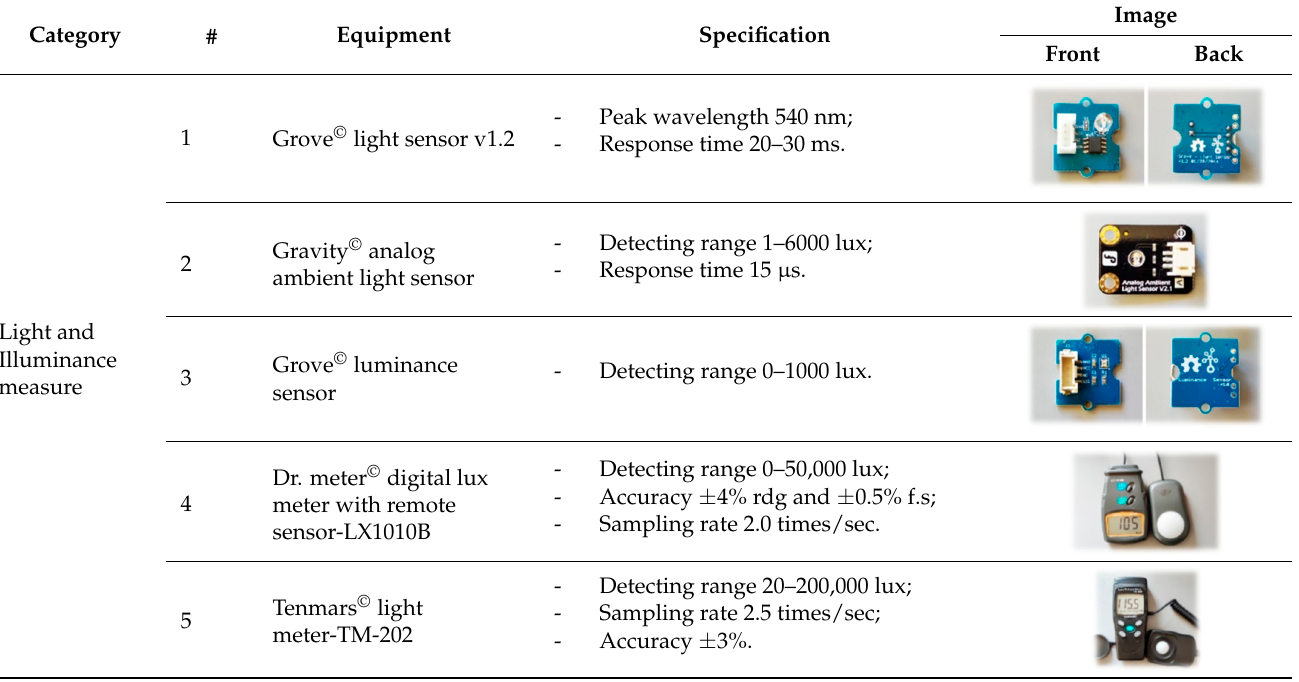
Table 3. The equipment for validating the results and providing the shade movement system with input.